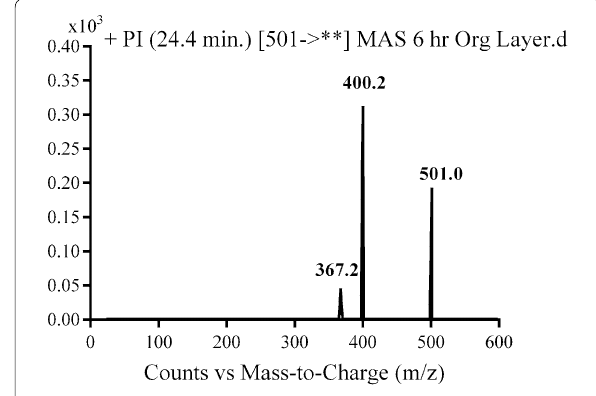
Fig. 5 PI mass spectrum of parent ion (M3) at m/z